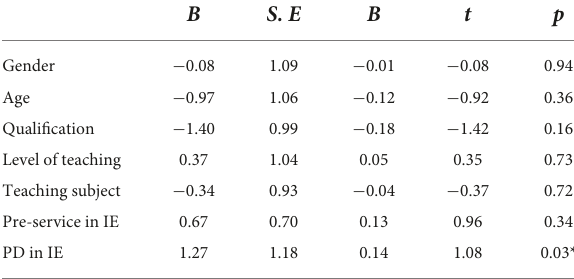
TABLE 4 Summary of demographics regressed on managing behaviour.